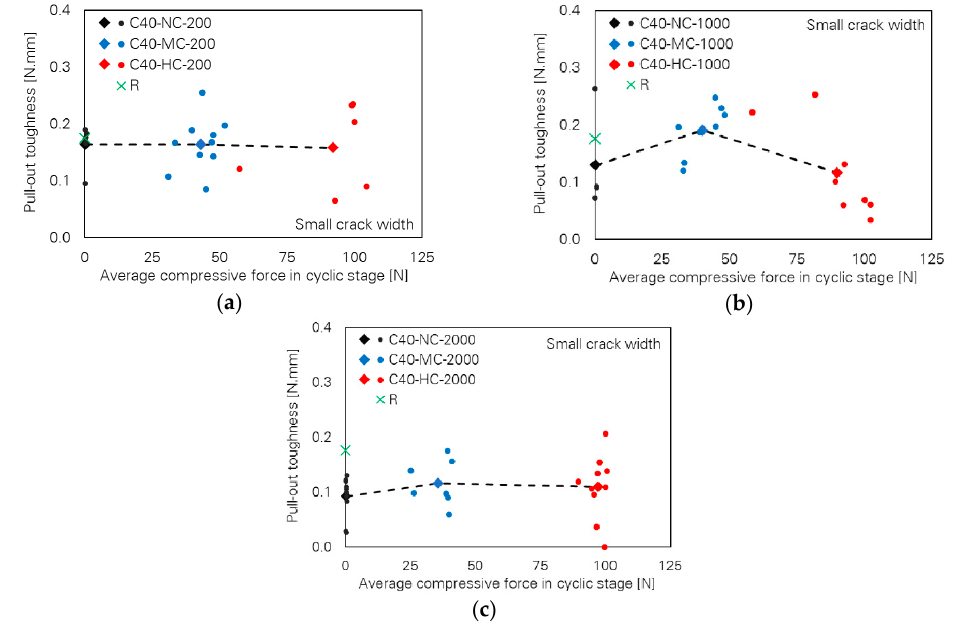
Figure 3. Influence of cyclic compressive force level on pull-out toughness of the specimens with small crack width; number of cycles: ( a ) 200, ( b ) 1000 and ( c ) 2000. Error! Reference source not found. shows slight differences between fibre force at rupture depending on cyclic compressive force and number of cycles. The values of force at rupture are very close, particularly for the cases with 2000 cycles; see Error! Reference source not found. c. This is also the case for the values of displacement at fibre rupture as shown in Figure 1. For any number of cycles, the displacement at rupture follows a nearly straight horizontal line with increasing compressive force; the differences are negligible. ( a ) ( b ) ( c )